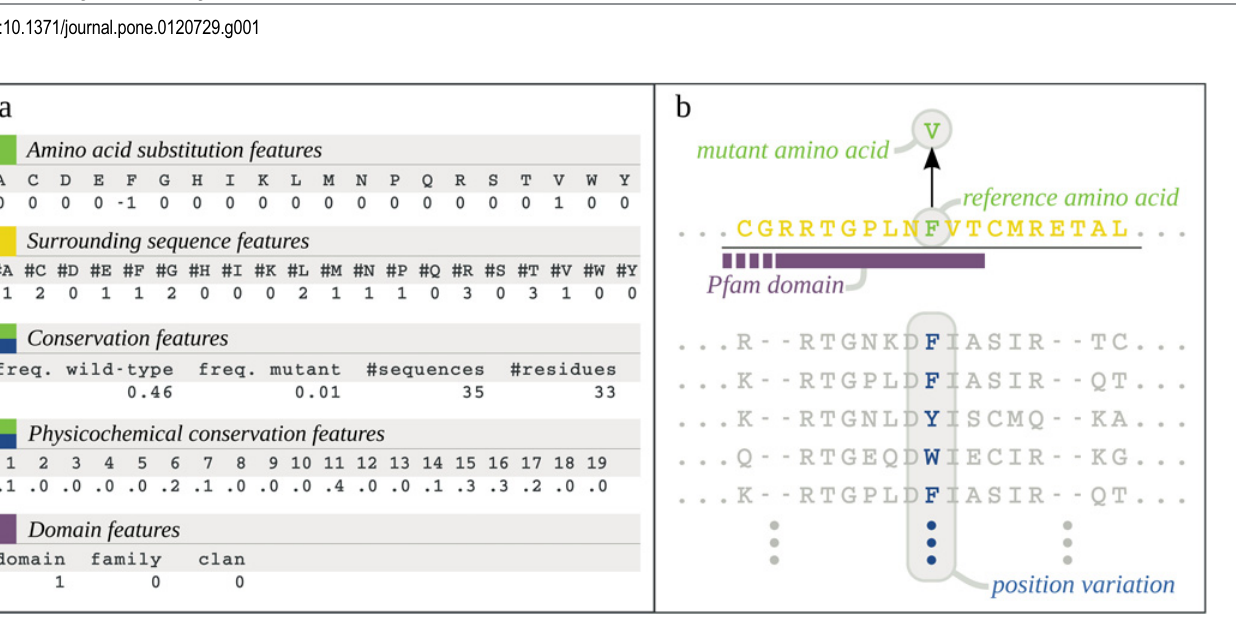
Fig 2. Feature categories. a) Five feature categories and their corresponding features. The colors indicates from which type of sequence data in part B the features were derived. b) Sequence and annotation data used to derive variant features; the amino acid substitution (green), the surrounding sequence (yellow), the amino acid variation in similar proteins (blue), and Pfam annotations (purple).